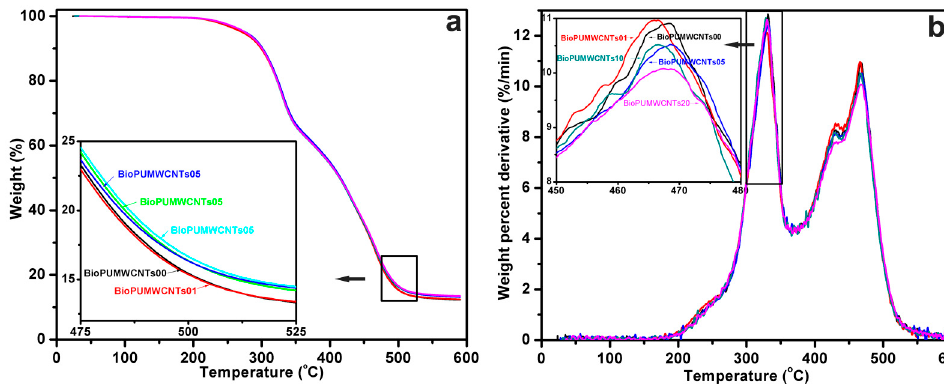
Figure 7. ( a ) Thermogravimetric analysis (TGA) and ( b ) derivative TGA curves recorded under nitrogen at 10 °C/min for the nanocomposite bioplastics